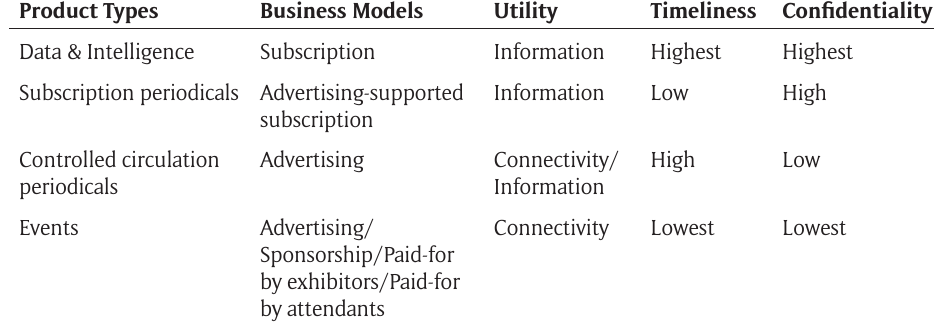
Table 1: B2B media products, business models, and